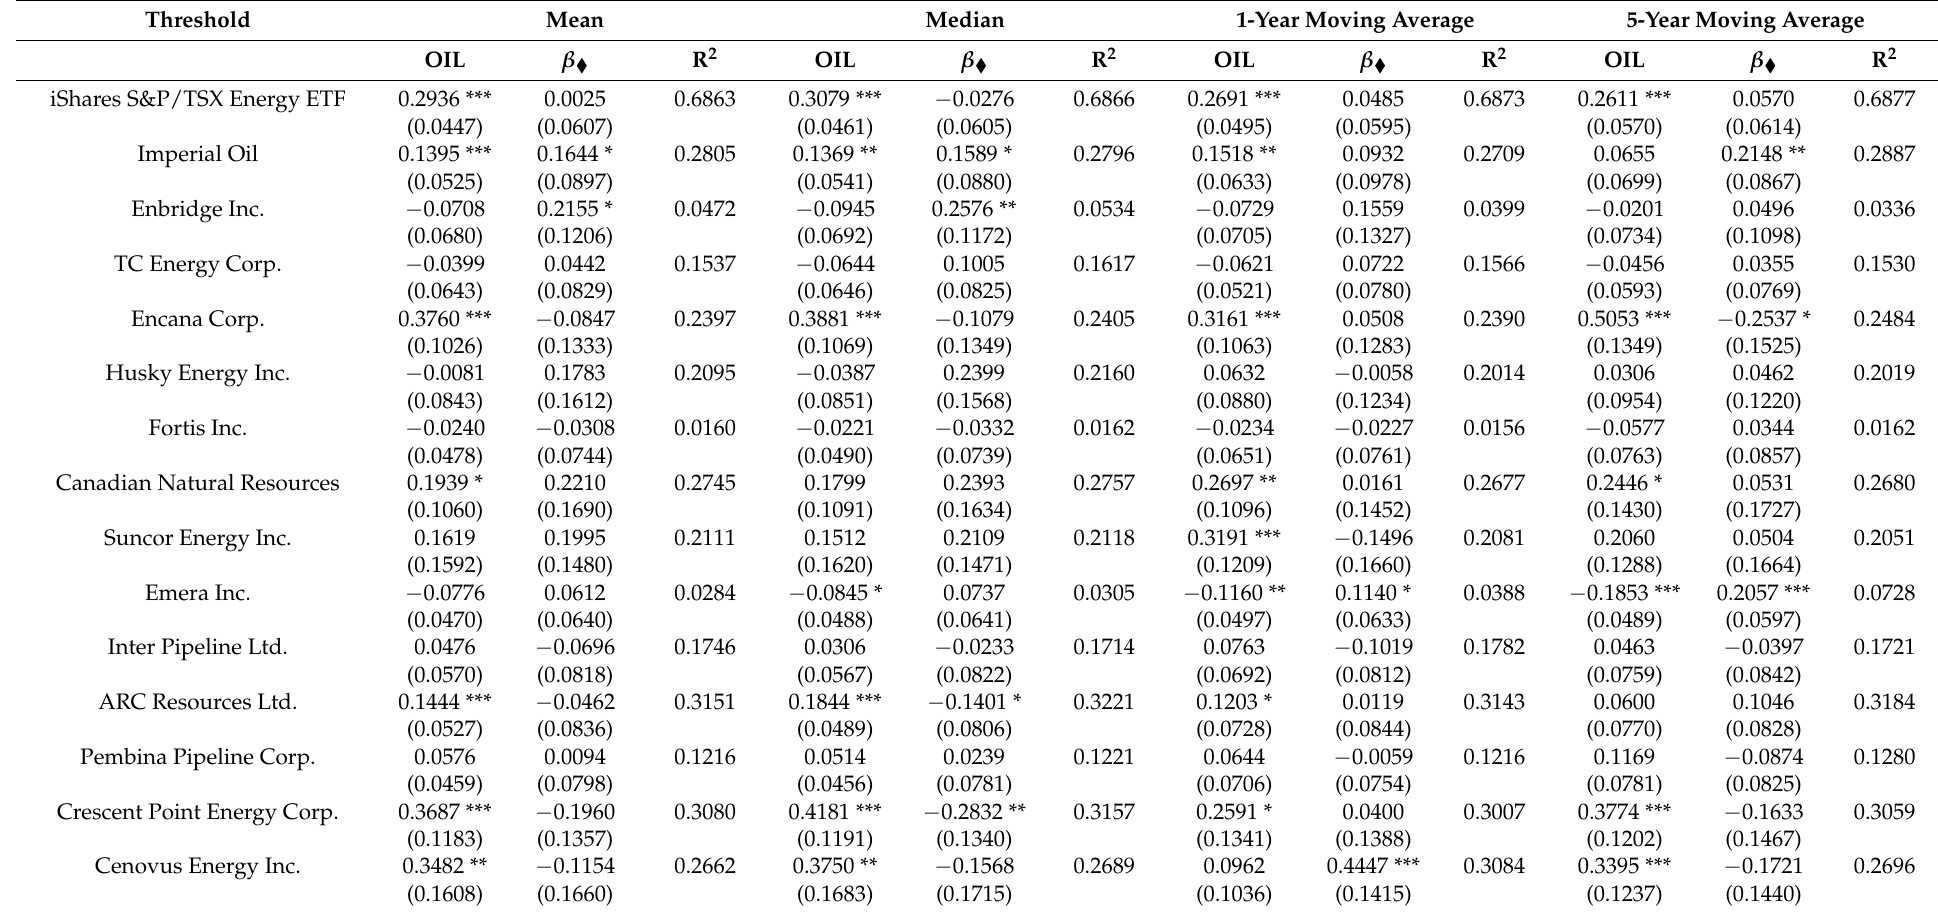
Table 5. Regression results—asymmetric model with